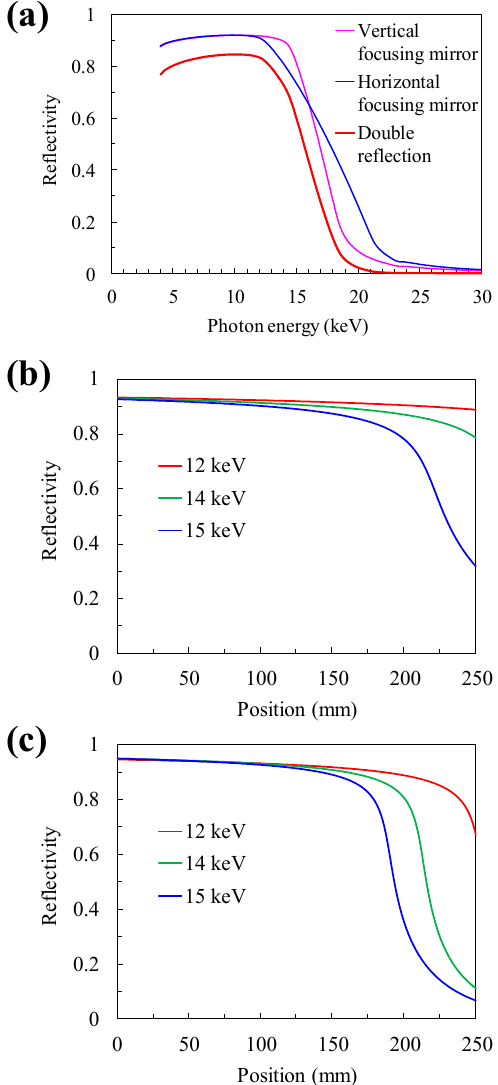
Figure 1. Calculated reflectivity of designed mirrors. ( a ) Dependence of reflectivity on the incident photon energy. ( b ) Dependence of reflectivity on the surface position of the vertical focusing mirrors and ( c ) the horizontal focusing mirrors. Position 0 mm shows the upstream edge of the focusing mirror. The change in reflectivity is due to variation in the incident angle along the elliptical cylinder surface.